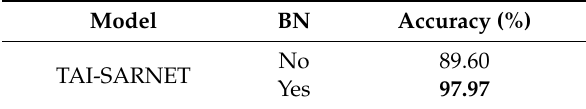
Table 6. Modelling performance of Batch Normalization (BN)